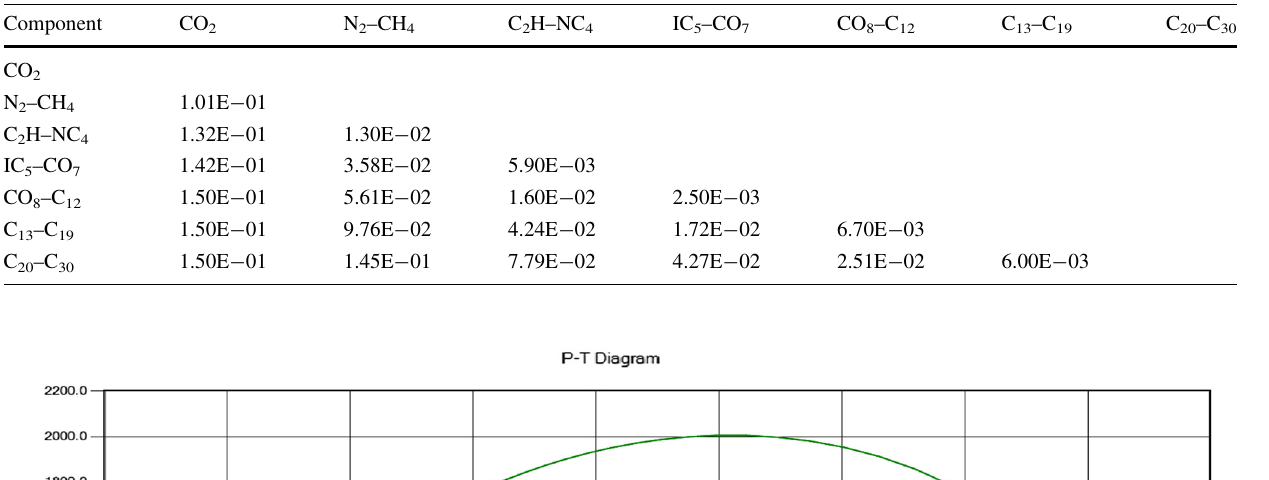
Table 4 Binary interaction coefficients for Bakken